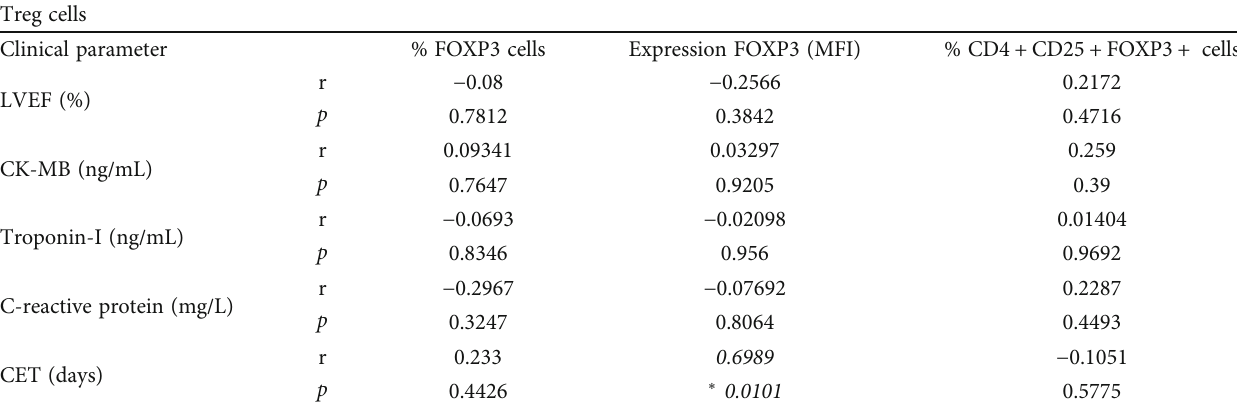
Table 4: Correlation between Treg cells and di ff erent clinical parameters. Treg